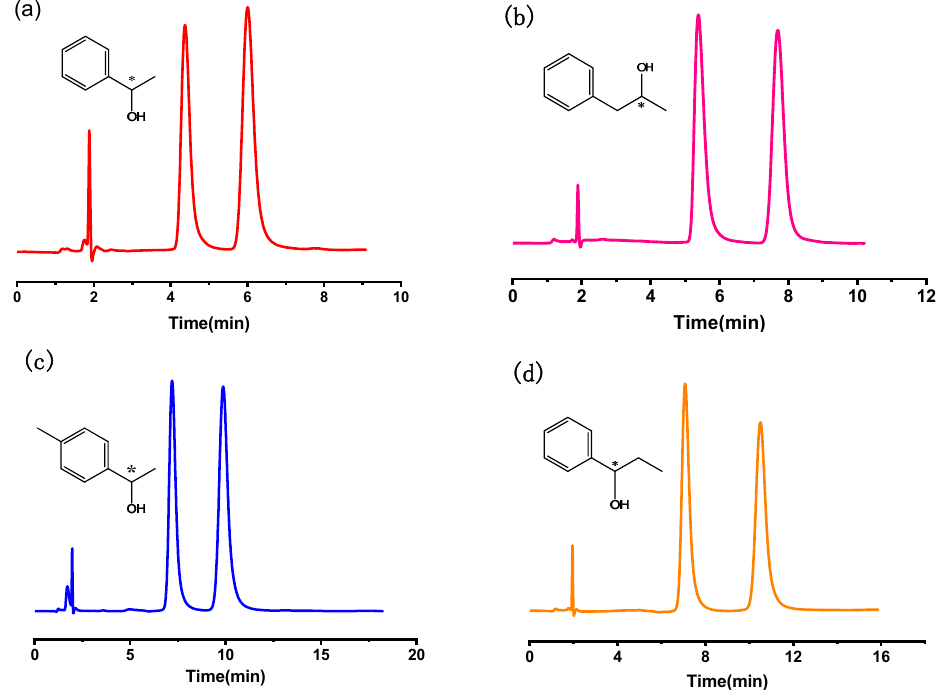
Figure 1. Chromatogram of ( a ) phenyl ethanol, ( b ) 1-phenyl-2-propanol, ( c ) p-methyl phenyl-ethanol, ( d ) 1-phenyl-1-propanol on the RCC3-C10@silica molecular cage column. Mobile phase: 40% methanol/water ( v / v ); Flow rate: 1.0 mL/min; UV: 254 nm. Table 1. Chromatographic parameters of chiral drugs on the RCC3-C10@silica molecular cage column.